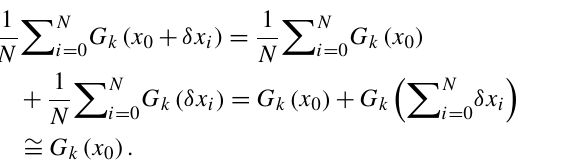
Figure 1. Globally averaged profiles of historical ECMWF 4D-Var differences M sation 9h into the 12h assimilation window for vorticity (a) and divergence (b) in 2004, 2008, 2013 and 2017. Over the years, the resolution and number of inner and outer loops have increased from 60-level TL511/TL95-TL159 in 2004 to 137-level TCo1279/TL255-TL319-TL399 in